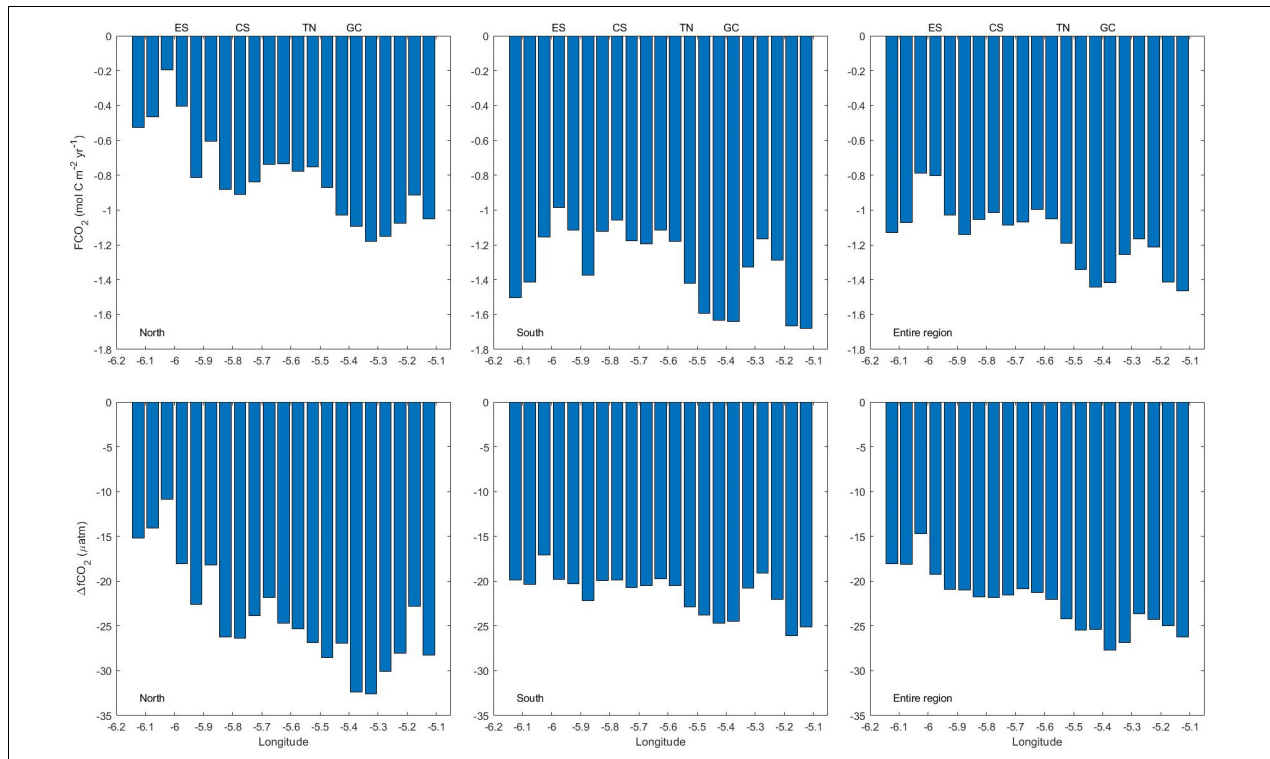
FIGURE 5 | Annual average of FCO 2 and (cid:49) f CO 2 every 0.05 ◦ longitude calculated along the northern and southern sections and in the entire region.